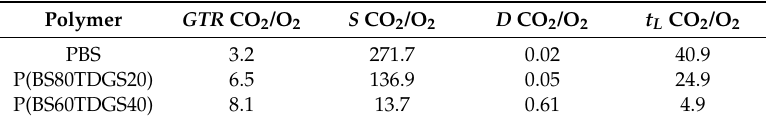
Table 10. CO 2 /O 2 ratios of permeability coefficients for untreated